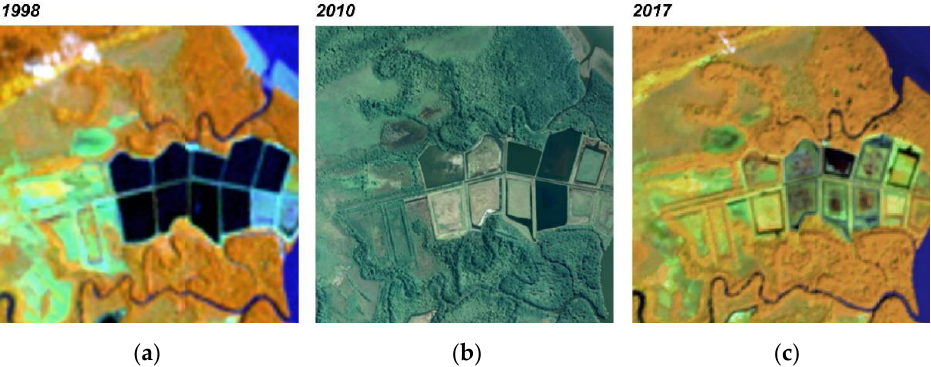
Figure 5. Land occupation and abandonment of shrimp farms in the Bocana de Limones sector, in the Esmeraldas province. ( a ) In the 1998 satellite image, shrimp ponds are shown in dark color and mangroves are shown in reddish-brown; ( b ) in the 2010 satellite image, some abandoned pools with recovering mangroves can be observed; ( c ) finally, in the 2018 satellite image, abandoned shrimp farms covered by mangroves can be observed on the left and right sides.